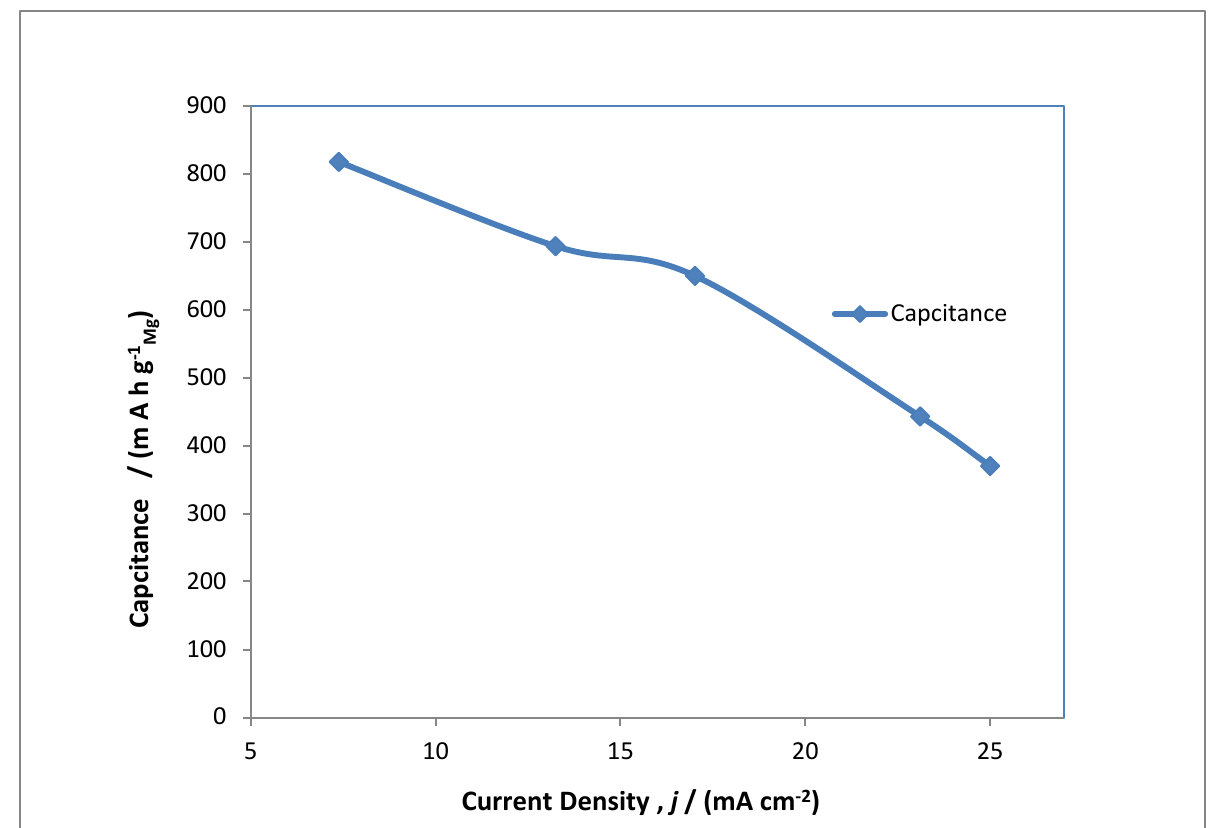
Figure 6. Energy density profile for a MAB at applied current densities of 7, 13, 17, 23 and 25 mA cm − 2 .